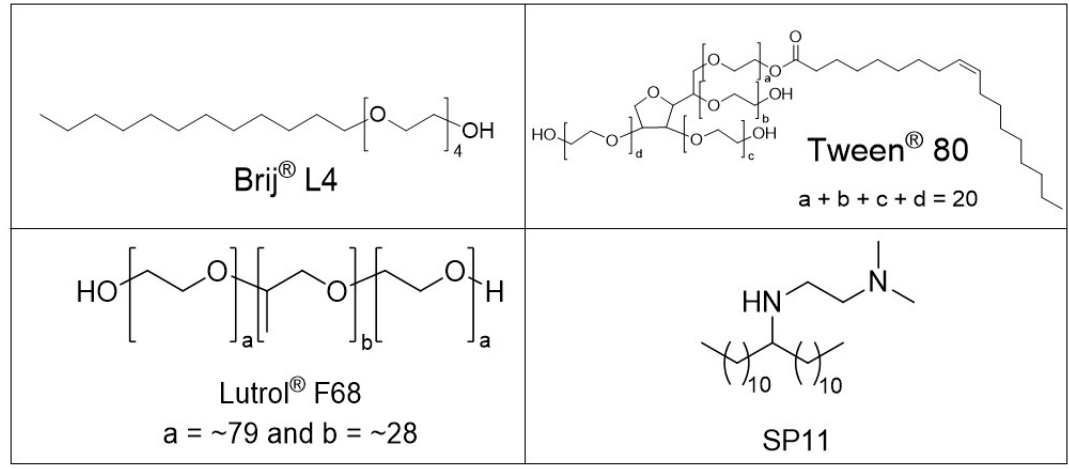
Figure 4. Chemical structures of the surfactants used in the preparation of the MC-B4 and MC-SP11 magnetic nanocarriers.